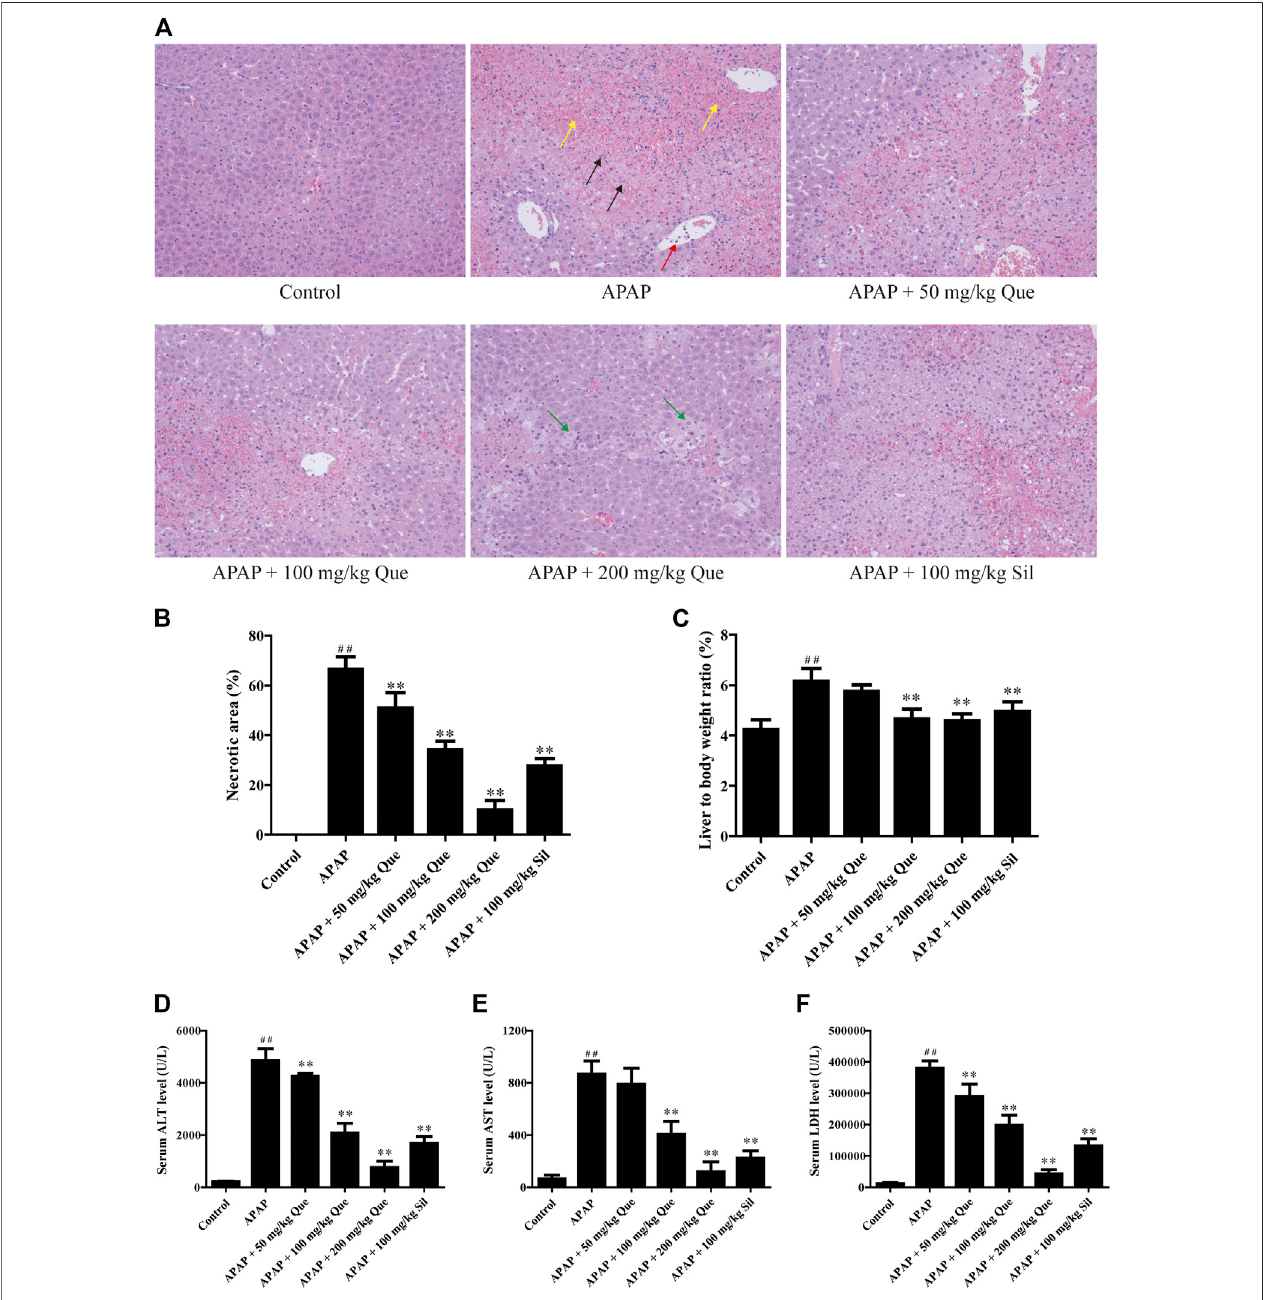
FIGURE 2 | Effectof quercitrin on APAP-induced acute liver injury in mice. (A) Pathological evaluation of the liver tissueof mice (H & E staining 200 × ). Black arrows show cell nuclei fragmentation; yellow arrows show hepatic sinusoidal congestion; red arrow shows neutrophil aggregation; green arrows show hepatocyte edema. (B) Necrotic area of the liver tissue. (C) Effect of quercitrin on liver organ coef fi cients of mice. (D – F) Analysis of ALT, AST, and LDH contents in the serum of mice. The experimental data are presented as mean ± SD, ## p < 0.01, compared with the control group; ** p < 0.01, compared with the APAP group.